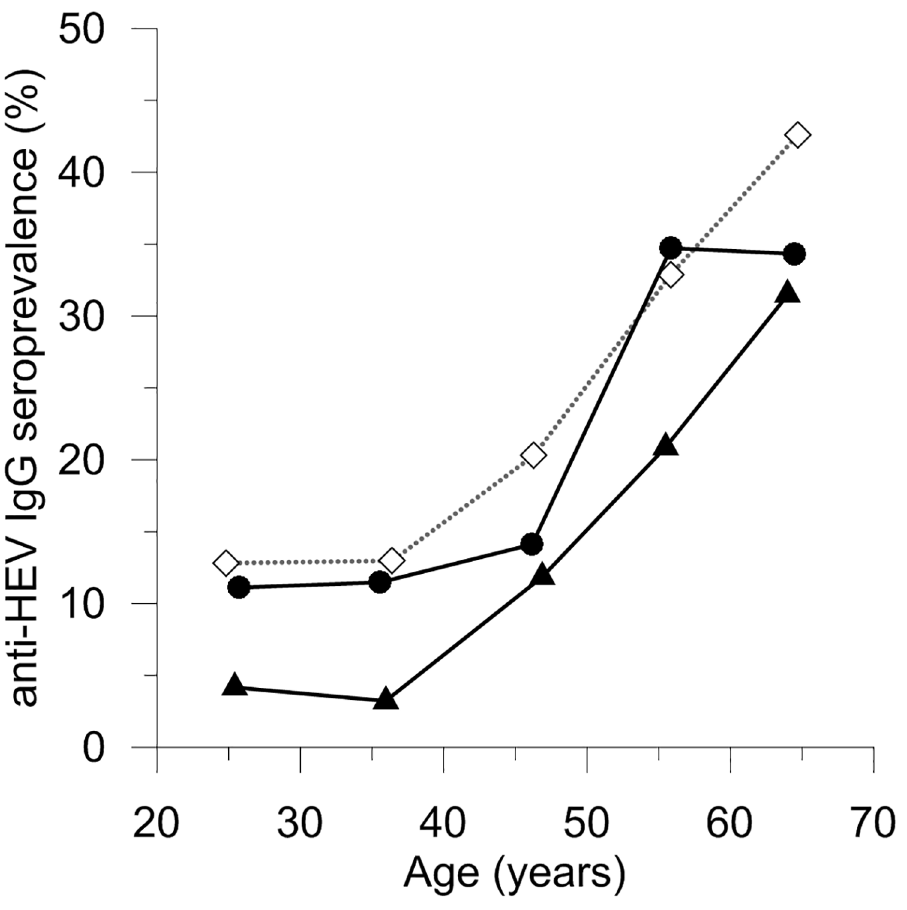
Fig 1. Anti-HEV prevalence in donors with a vegetarian lifestyle (triangles) and donors who consume meat on a daily basis (circles). For comparison, the age-dependent seroprevalencefrom our previous study is